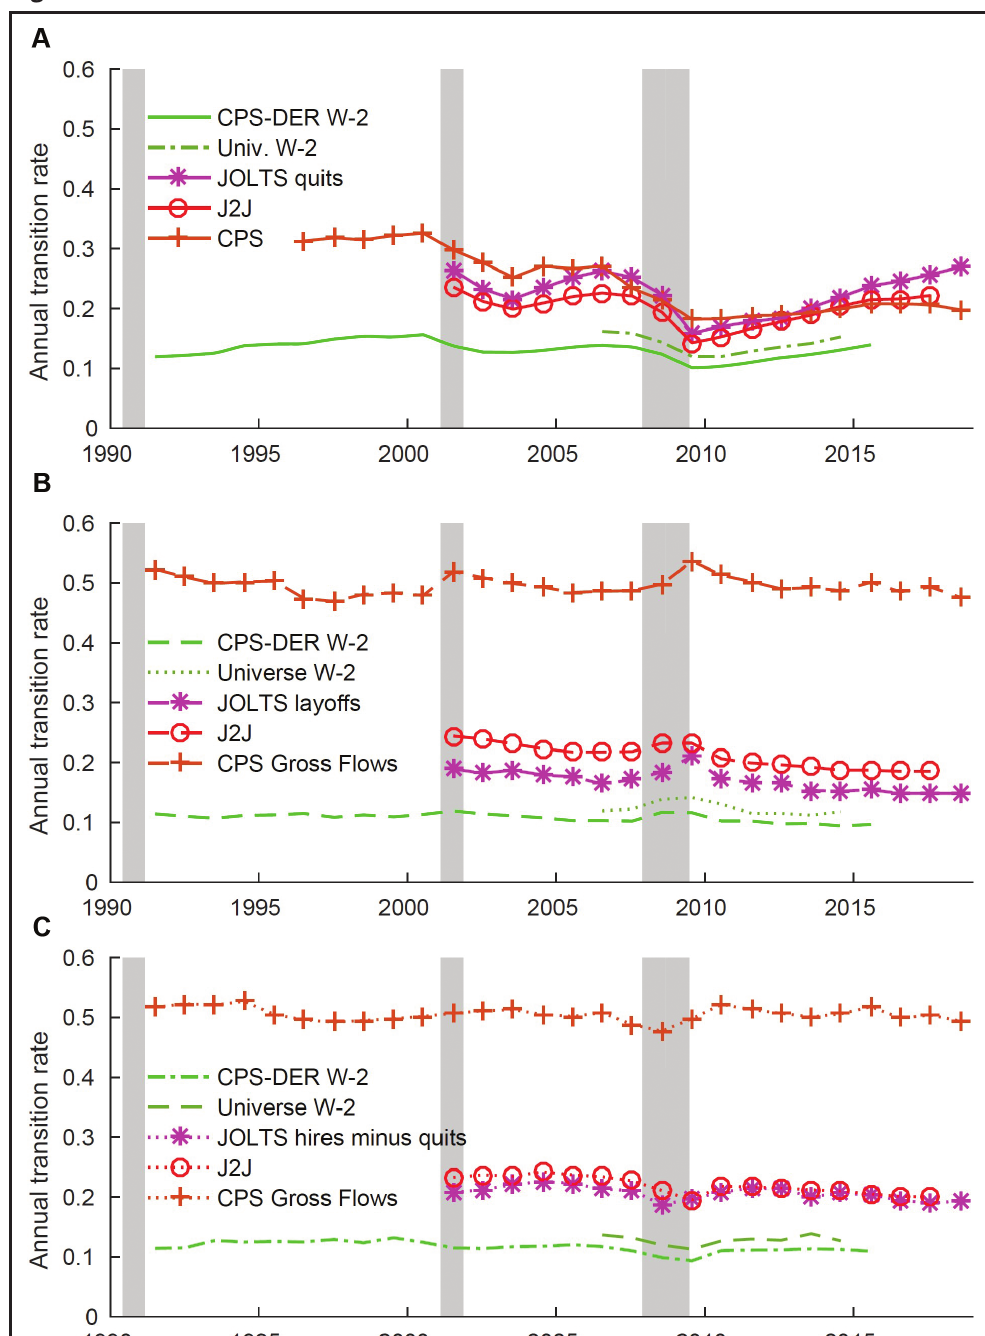
Figure E4 Annual transition